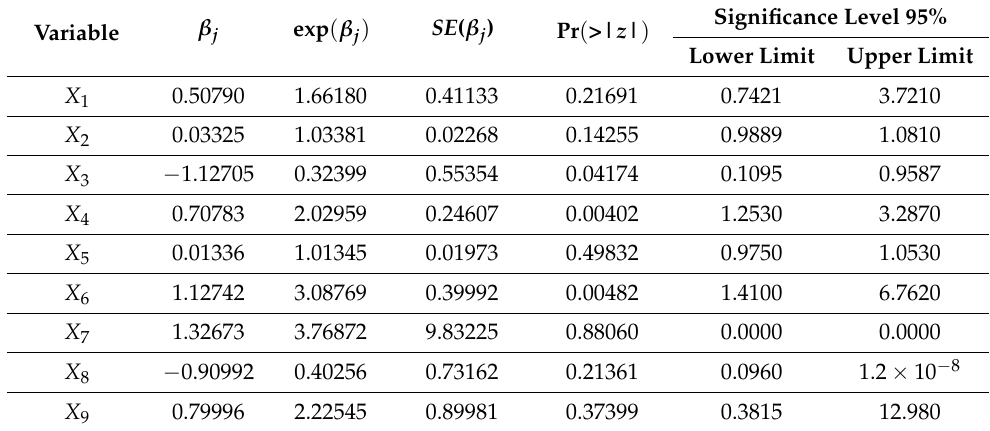
Table 9. Parameter estimation of Cox proportional hazard model with Efron